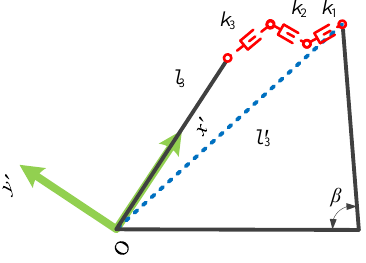
Figure 10. Equivalent opposite